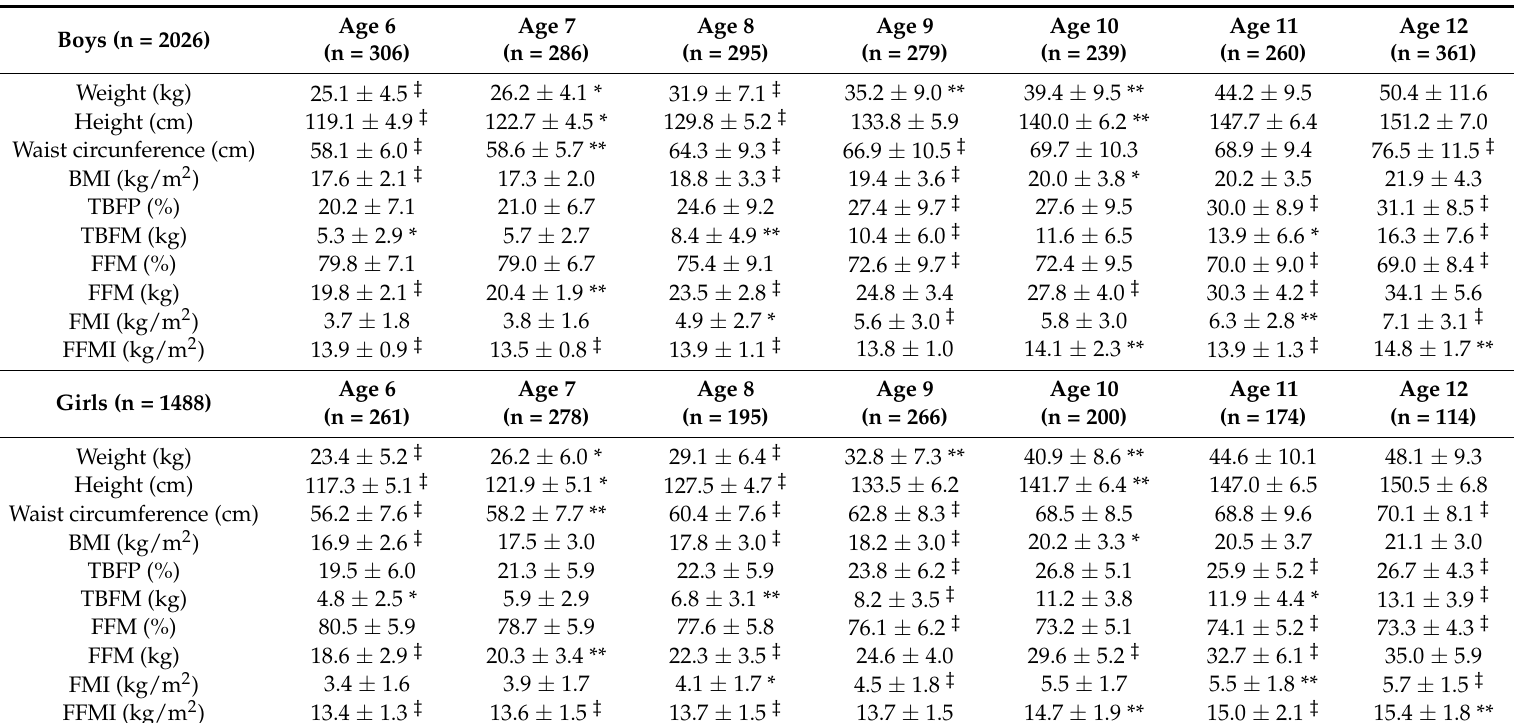
Table 1. Anthropometric and body composition characteristics (N =